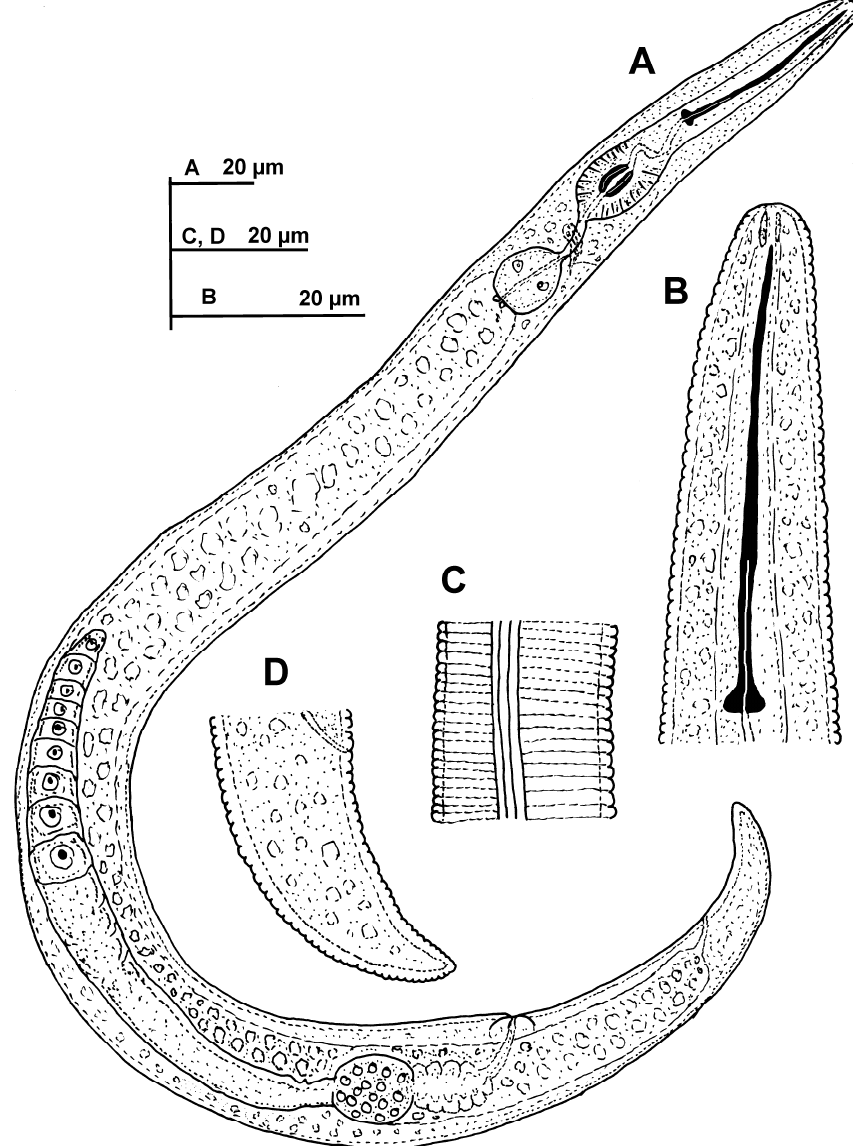
Figure 4. Line illustrations of Paratylenchus plesiostraeleni sp. nov. ( A ) Whole female; ( B ) Female stylet region; ( C ) Detail of lateral fields at mid-body; ( D ) Female tail.